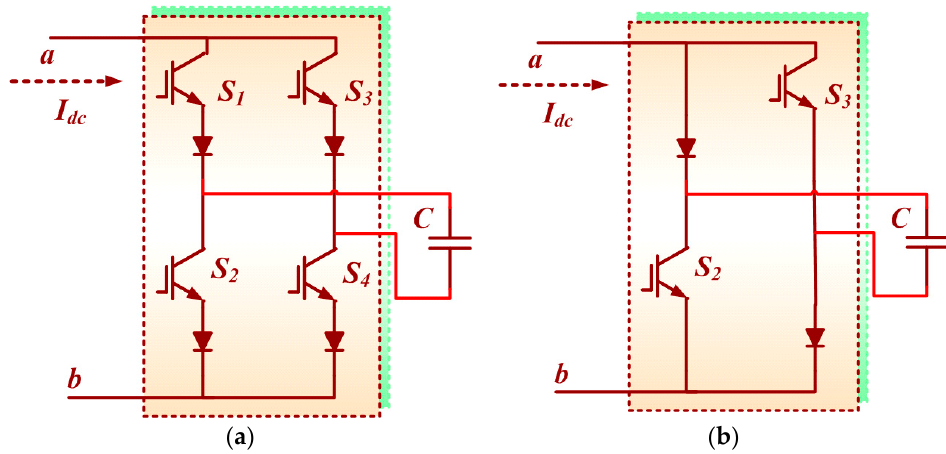
Figure 3. ( a ) H-bridge decoupling circuit; ( b ) Simplified H-bridge decoupling circuit.